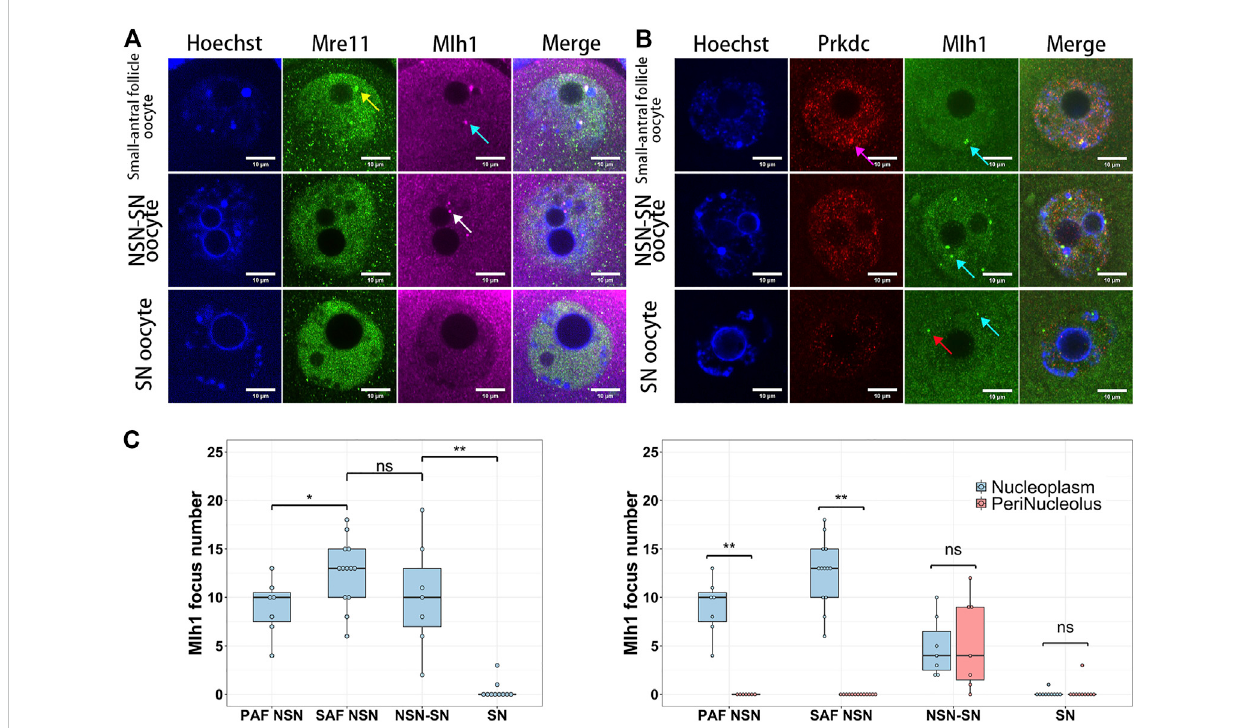
ThedynamicsofDNArepairproteinsinoocytes.BothMre11andPrkdcformedfocuscannotbedetectedintheNSN-SNorSNoocytes,butMlh1foci canbedetected inNSN-SNoocytesand someSNoocytes (A and B) . (C) The statisticsofMlh1 focusnumberingrowingandfullygrown oocytes.InNSN- SN oocytes, Mlh1 foci can migrate to the peri-nucleolus regions (white arrow). Mre11 focus, yellow arrow; Prkdc focus, magenta arrow; Mlh1 foci, cyan arrows; scale bars, 10 μ m; *, 0.01 < p < 0.05; **, p < 0.01; ns, non-signi fi cant. DNA are stained by Hoechst